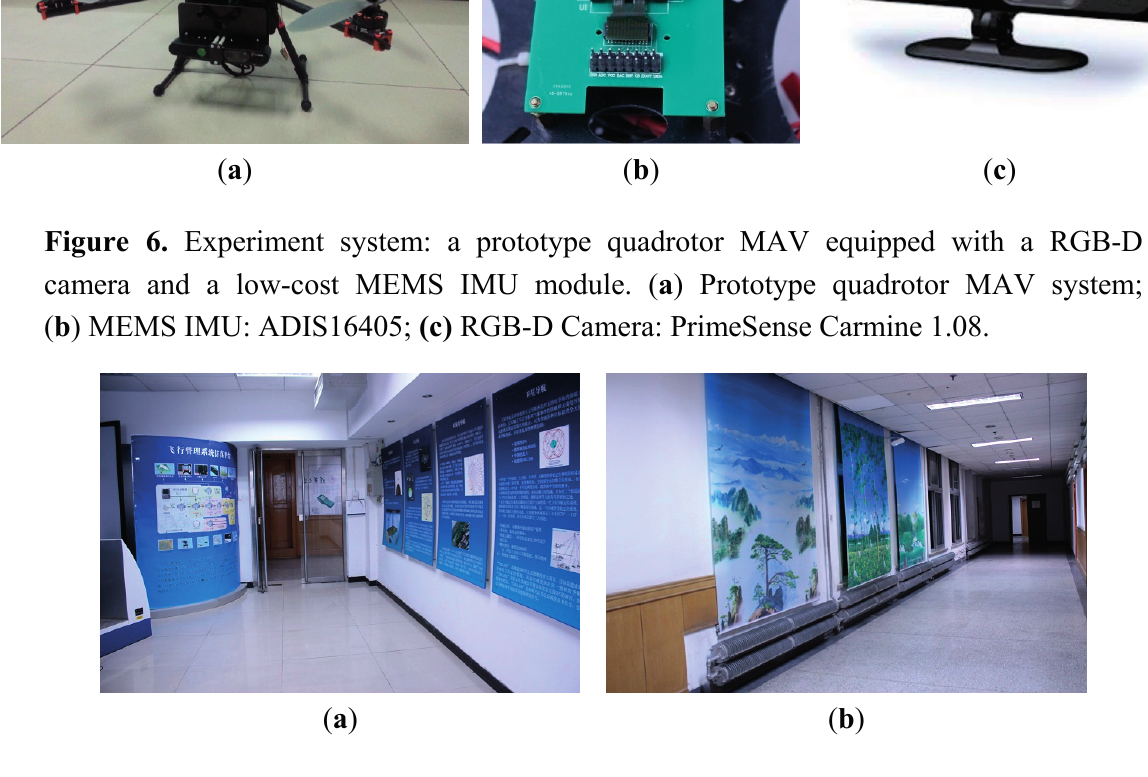
Figure 7. Indoor flight test scenarios. ( a ) Scenario 1: an actual laboratory; ( b ) Scenario 2: a corridor inside a building. Both environments are without access to GPS